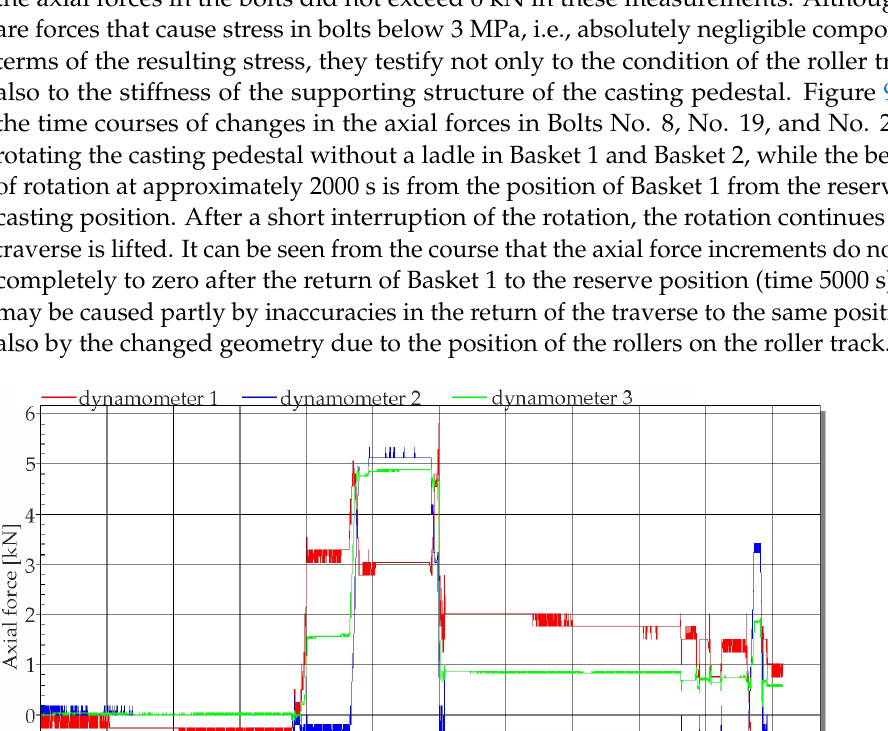
Figure 10. The time courses of axial forces in Bolts No. 8, No. 19, and No. 24 when loading the empty ladle into Basket 1 and rotating the pedestal to the casting position.